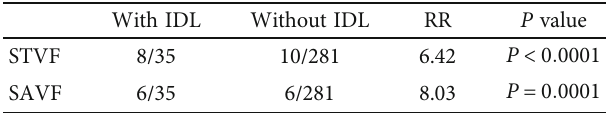
Table 4: The independent risk factor analysis of intervertebral disc leakage for subsequent vertebral